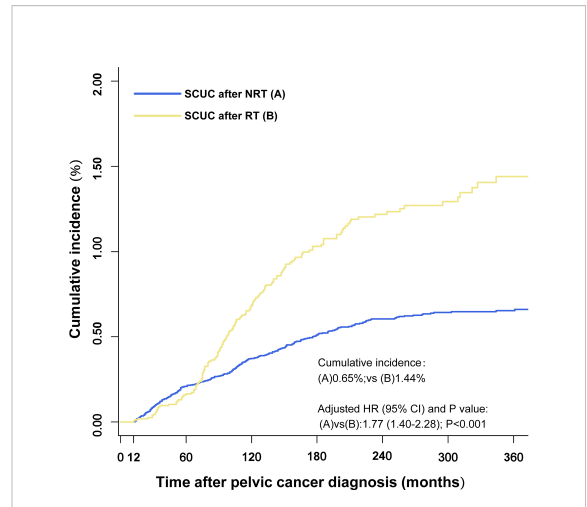
FIGURE 2 Comparisons of the cumulative incidence of secondary corpus uteri cancer (SCUC) between patients who received radiation therapy (RT) and patients who did not receive RT (NRT) in primary pelvic cancer (PPC) patients. The adjusted hazard ratios (HR) were adjusted for age at PPC diagnosis, tumor site, and chemotherapy by multivariable competing risk regression analysis. RT, radiation therapy; NRT, no radiation therapy; HR, hazard